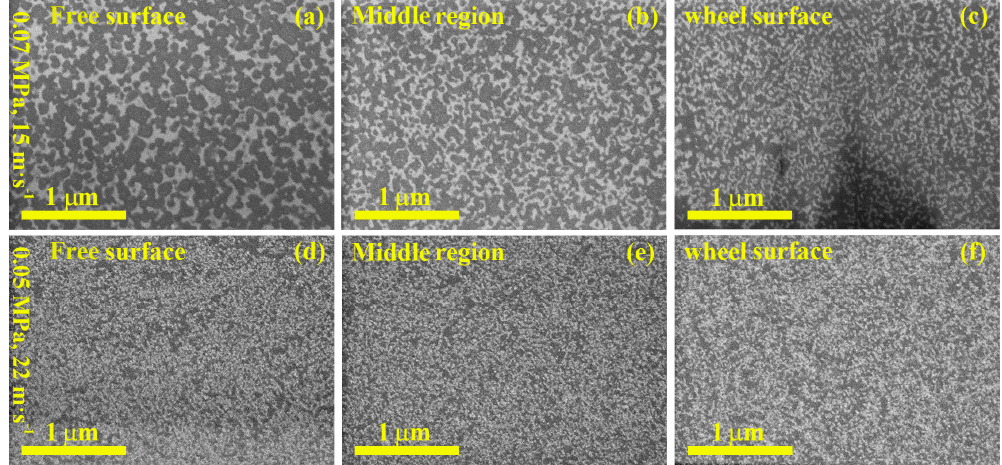
Figure 4. Cross-sectional back-scattered scanning electron microscope (SEM) images of as-spun Ce 17 Fe 78 B 6 ribbons produced at the wheel speed of 15 m·s − 1 and the chamber pressure of 0.07 MPa ( a – c ), and the ribbon spun at the wheel speed of 22 m·s − 1 and the chamber pressure of 0.05 MPa ( d – f ). Both samples showed two different grey levels suggesting the presence of two phases, which was consistent with the XRD results. Because CeFe 2 contains more Ce than Ce 2 Fe 14 B, the lighter contrasted regions were considered as CeFe 2 .